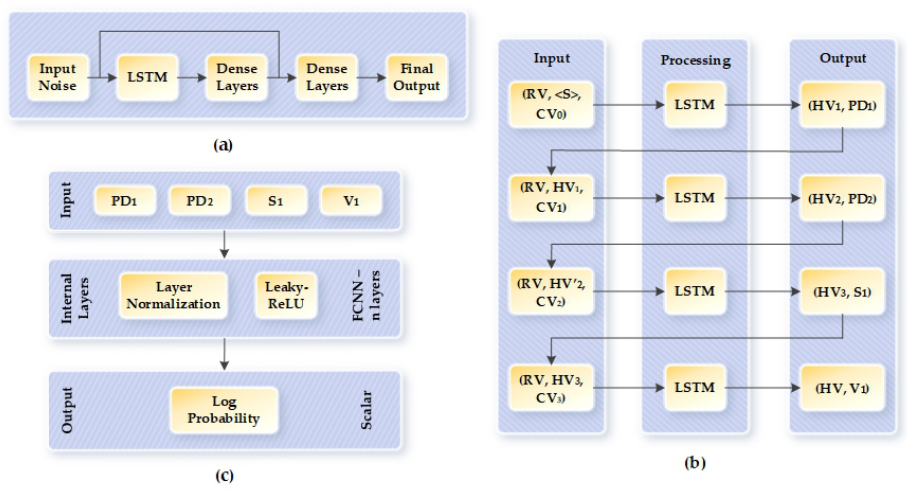
Figure 6. Layout of TGAN-skip–WGAN-GP: ( a ) Layout of TGAN-skip architecture. ( b ) Architecture of the generator. ( c ) Architecture of the discriminator. TGAN—Temporal generative adversarial network; WGAN—Wasserstein GAN; GP—gradient